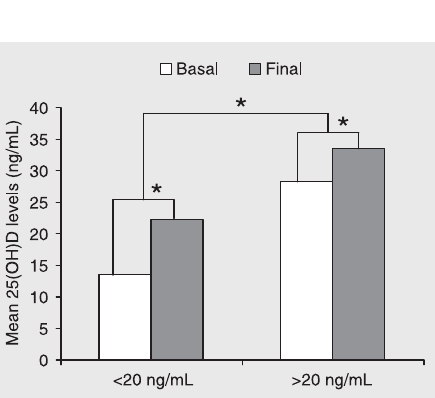
Figure 1. Effect of cholecalcif- erol on plasma 25(OH)D (ng/ mL) at the beginning of the study and after 12 weeks. The sub- jects received 7000 IU/week of cholecalciferol. 25(OH)D = 25- hydroxyvitamin D.